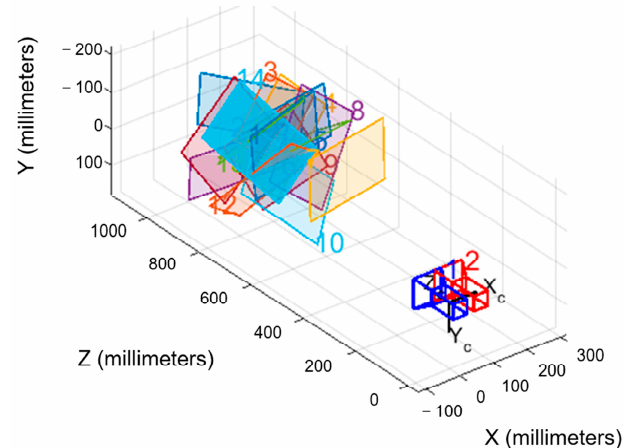
Figure 2. Spatial Distribution of Calibration Plate.